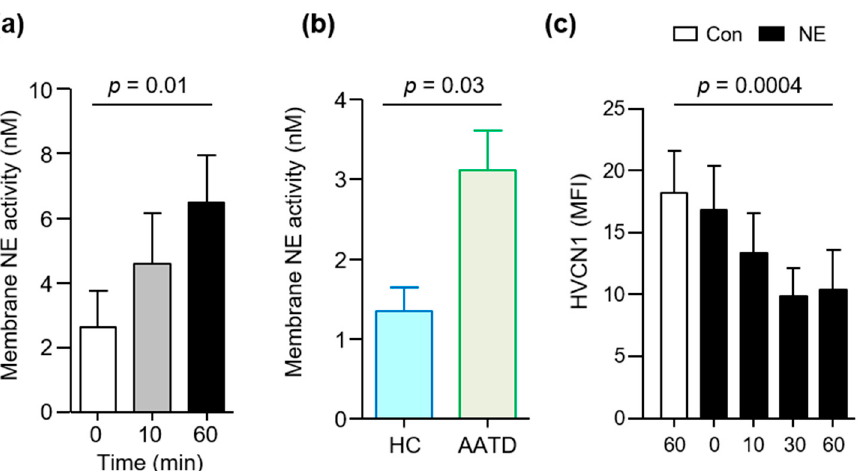
Figure 3. NE activity on AATD neutrophil membranes cleaves HVCN1. ( a ) Significantly increased NE activity on healthy control (HC) neutrophil plasma membranes after TNF- α (10 ng)/fMLP (10 µ M) stimulation ( n = 5 biological repeats, as measured by FRET assay ( p = 0.01, one-way ANOVA, post hoc Bonferroni test)). ( b ) Activity of NE on unstimulated HC or AATD neutrophil plasma membranes. AATD neutrophils exhibit significantly increased activity of NE compared to HC ( n = 3 subjects per group, p = 0.03, Student’s t test). ( c ) HC neutrophils (2 × 10 6 ) were untreated (Con) or exposed to NE (20 nM) over a 60 min time course. Exposure to NE significantly reduced membrane expression of HVCN1 after 60 min ( p = 0.0004, n = 5, one-way ANOVA, post hoc Dunnetts’ test).